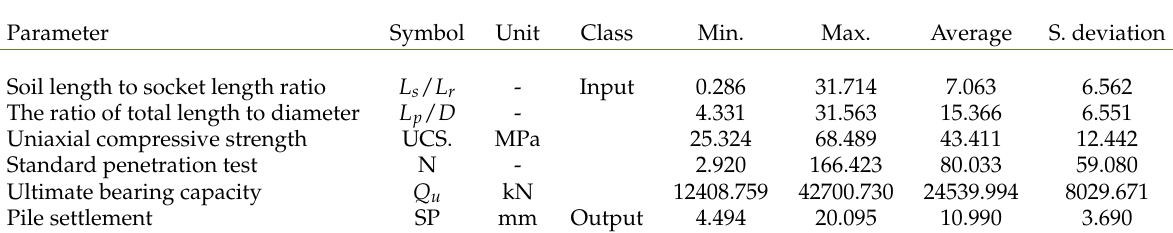
Table 1. The statistical values of the input and output variables